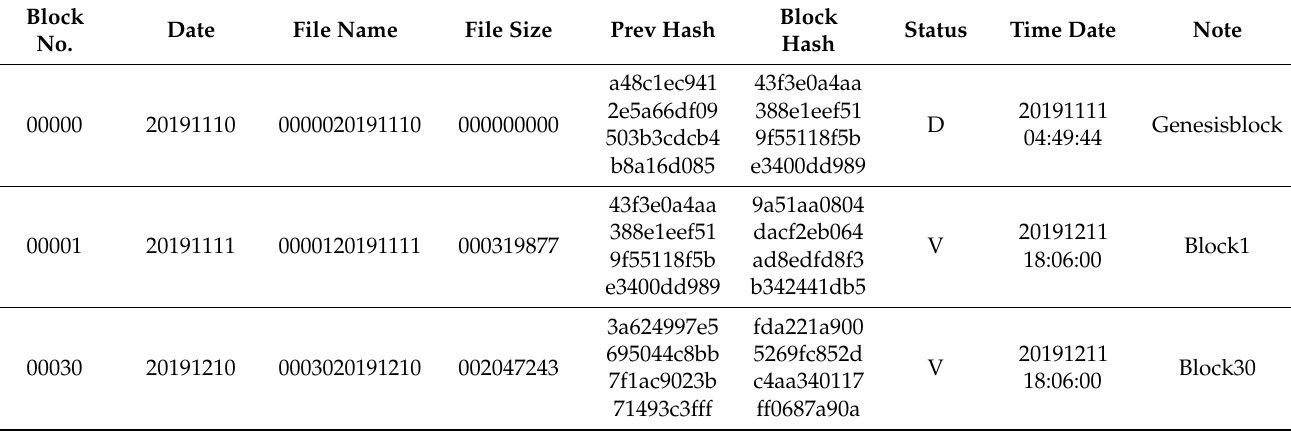
Table 8. Blockchain header file samples in normal